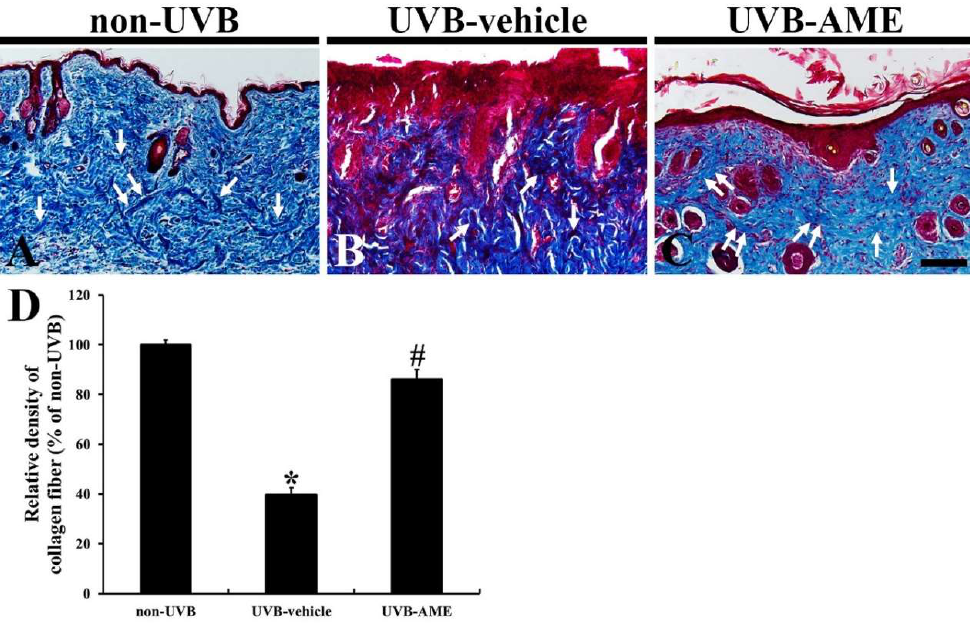
Figure 4. ( A – C ) Masson’s trichrome staining in the dorsal skin of the non-UVB (A), UVB-vehicle (B) and UVB-AME ( C ) at 7 days after UVB irradiation. Thick collagen fibers (arrows) are well stained with aniline blue in the dermis of the non-UVB group. In the UVB-vehicle group, significantly progressed fibrosis with reduction in collagen fibers is shown. However, in the UVB-AME group, the disruption of collagen fibers is attenuated. Scale bar = 100 μm. ( D ) Relative density of collagen fibers in the dorsal skin of each group at 7 days after UVB irradiation. Bars indicate the means ± SEM ( n = 10 in each group, * p < 0.05 vs. non-UVE group, # p < 0.05 vs. UVB-vehicle group).